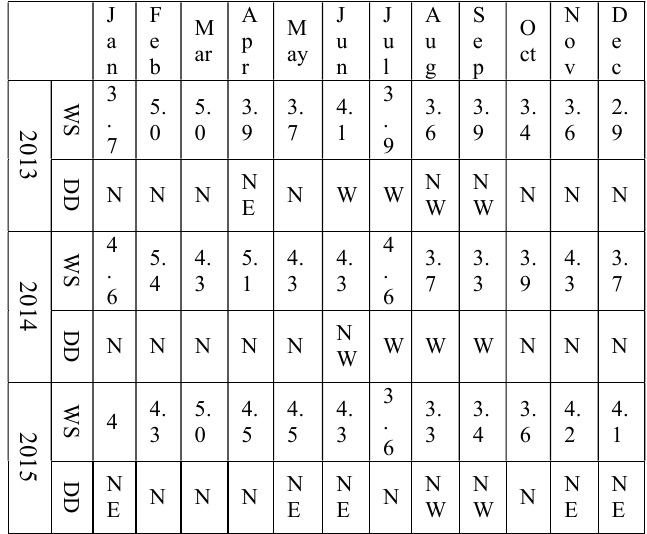
Table 1: M onthly averages and dominant direction of wind speeds in the Thies zone for 3 years. WS: wind speed (m/s), DD: dominant direction, N: north, NE: